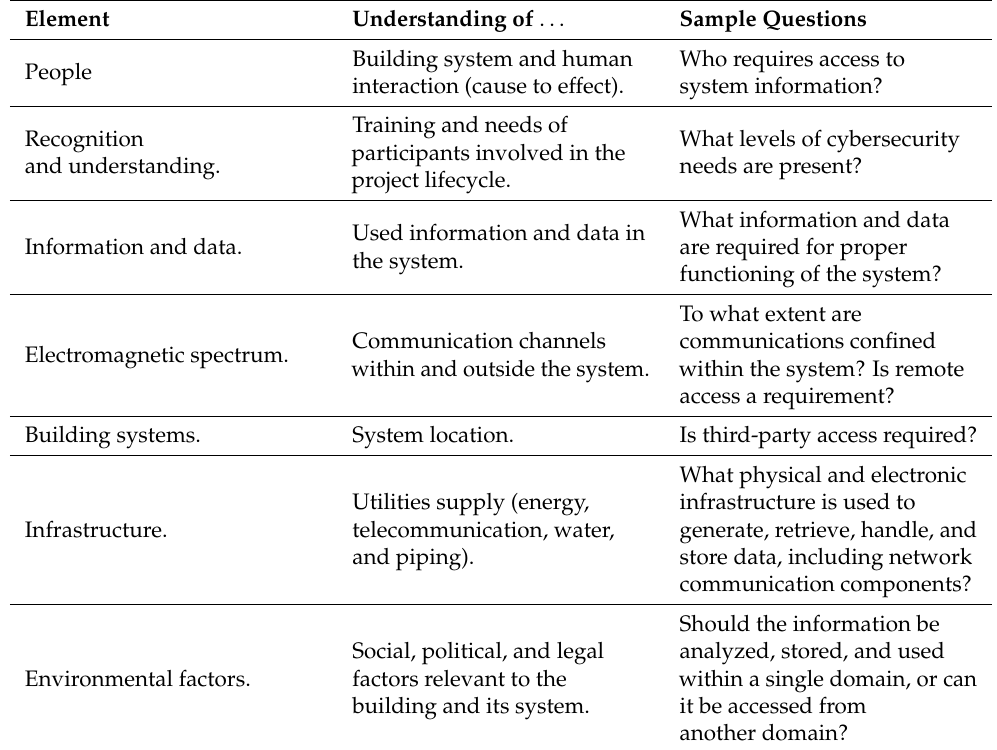
Table 3. Elements of the Cop-BCSE framework